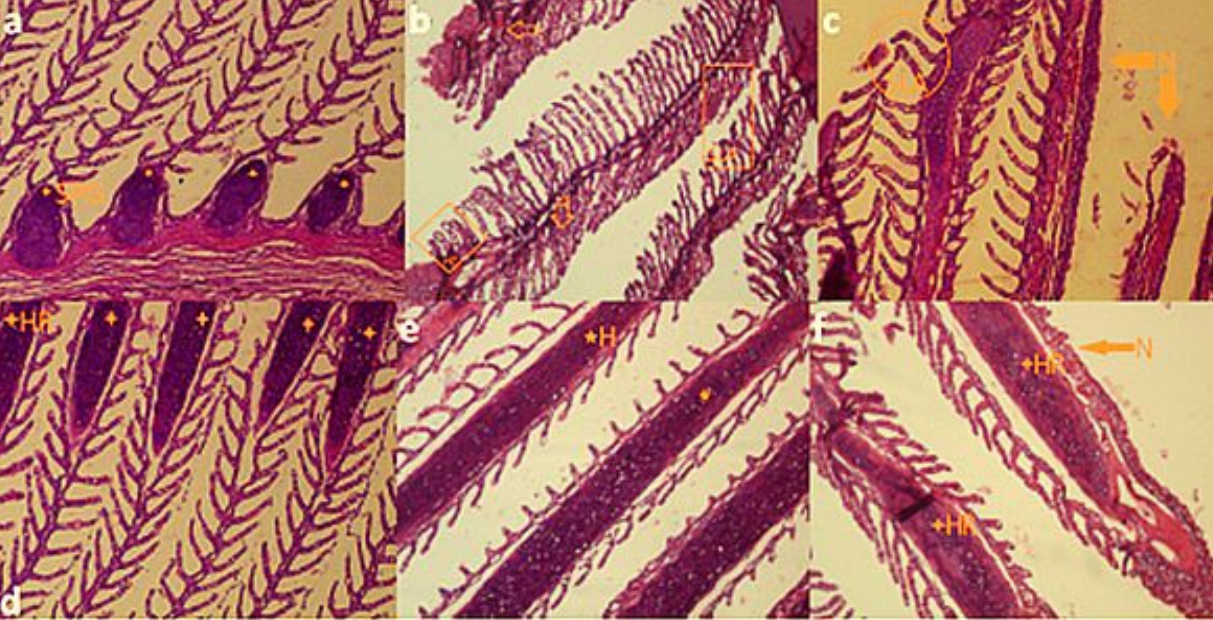
Figure 2. Photomicrographs of common carp ( C. carpio ) after 96 h exposure to lethal concentrations of commercial formulation of glyphosate (glyphosate Aria 41% SL suspension): ( a ) swollen primary gill (SPG) in 50 mL · L − 1 ; ( b ) hyperplasia (HP), hypertrophy (HT), secondary lamellar adhesion (SLA) and necrosis (N) of gills in 100 mL · l − 1 ; ( c ) secondary lamellar adhesion (SLA) and necrosis (N) of gills in 150 mL · L − 1 ; ( d , e ) hemorrhage (HR) and hyperemia (H) in 100 and 150 mL · L − 1 , respectively; ( f ) hemorrhage (HR) and necrosis (N) of gills in 150 mL ∙ L − 1 . All pictures are magnified ×10.